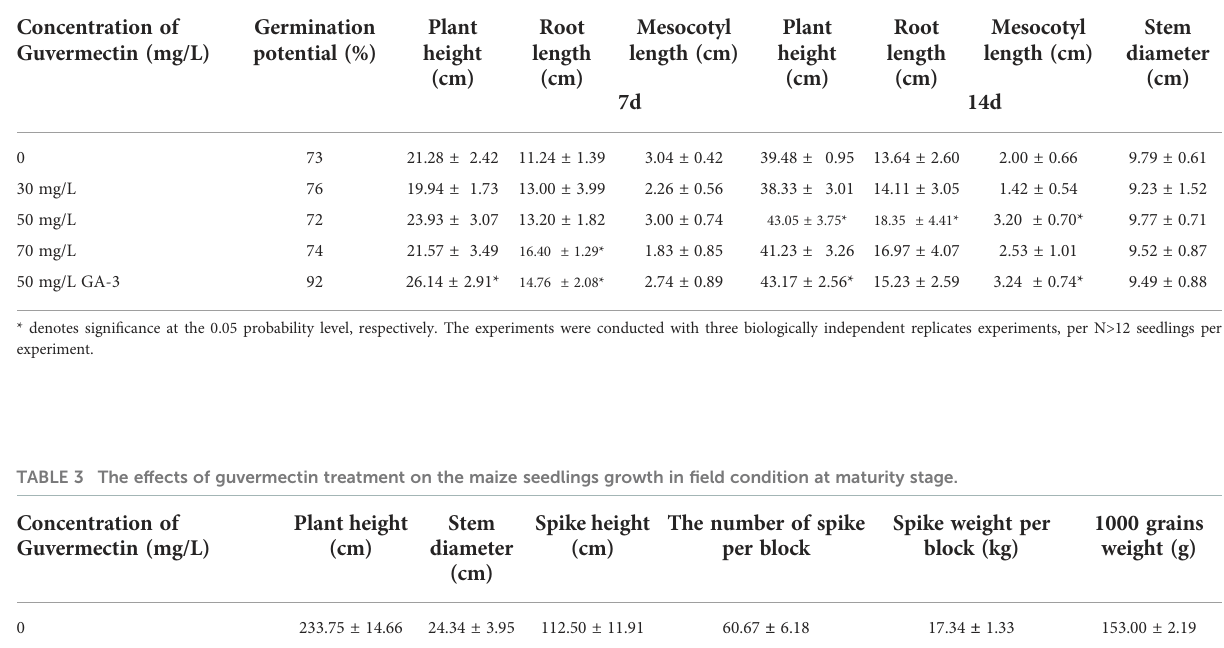
(Table 3). The other yield attributes (i.e., the number of spikes and 1000-grains weight) were not signi fi cantly different (Table 3). Compared with 0 mg/L guvermectin treated plant,